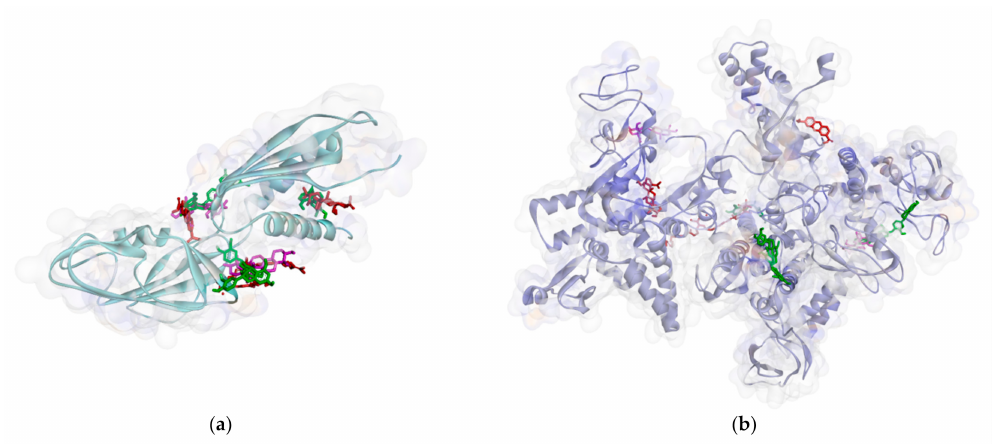
Figure 1. Chemical structures of M. pendans compounds: butein ( 1 ), biflavonoid ( 2 ), 3”- methoxy epicatechin-3- O -epicatechin ( 3 ), 2-dodecyl-4-hydroxylbenzaldehyde ( 4 ), 2-dodecyl-4- hydroxylbenzaldehyde ( 5 ), pomolic acid ( 6 ), betulin ( 7 ), and sitosterol-(6 (cid:48) - O -tridecanoil)-3- O - β - D-glucopyranoside ( 8 ).